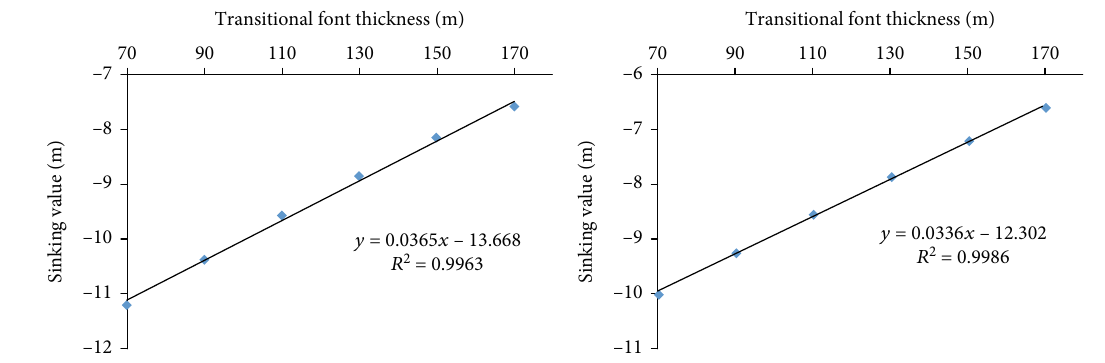
Figure 12: Fitting value and transition body thickness fi tting equation